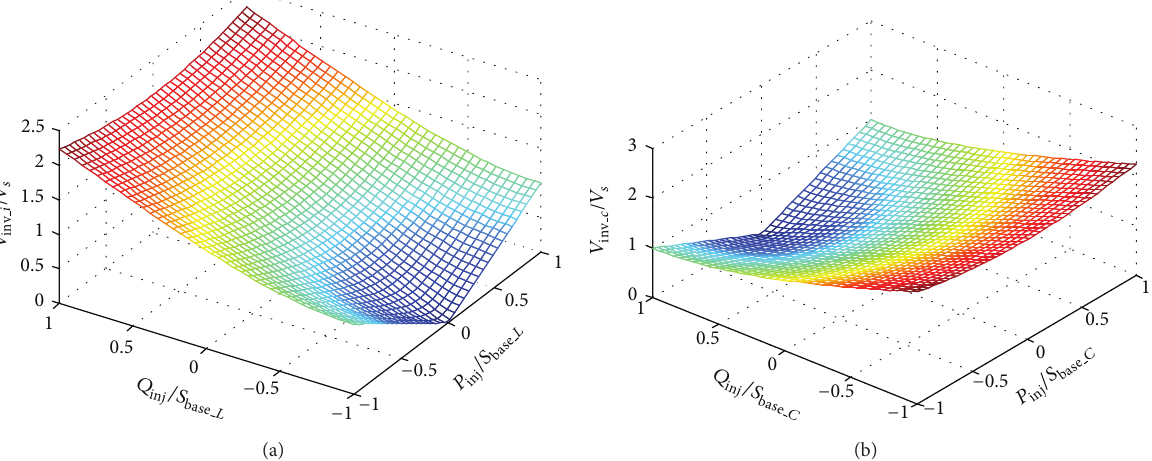
Figure 2: Operation voltage varies in terms of power flow.